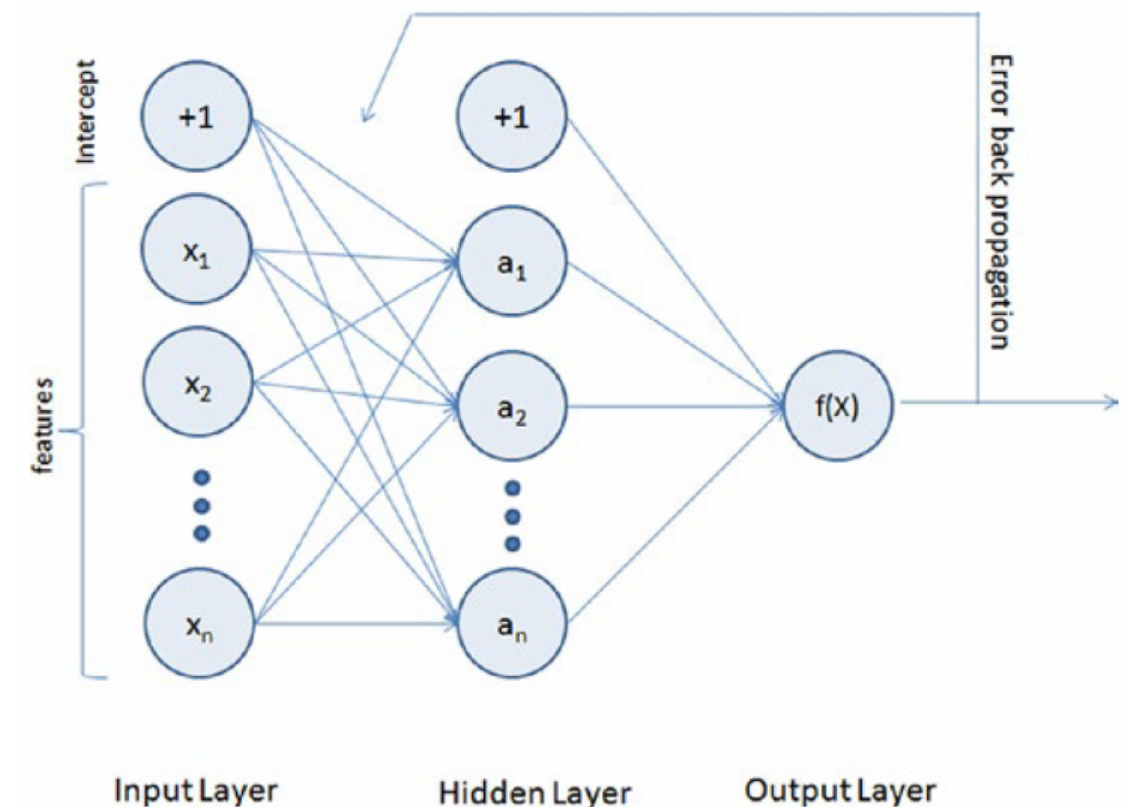
Figure 3. The basic architecture of the ANN with bias